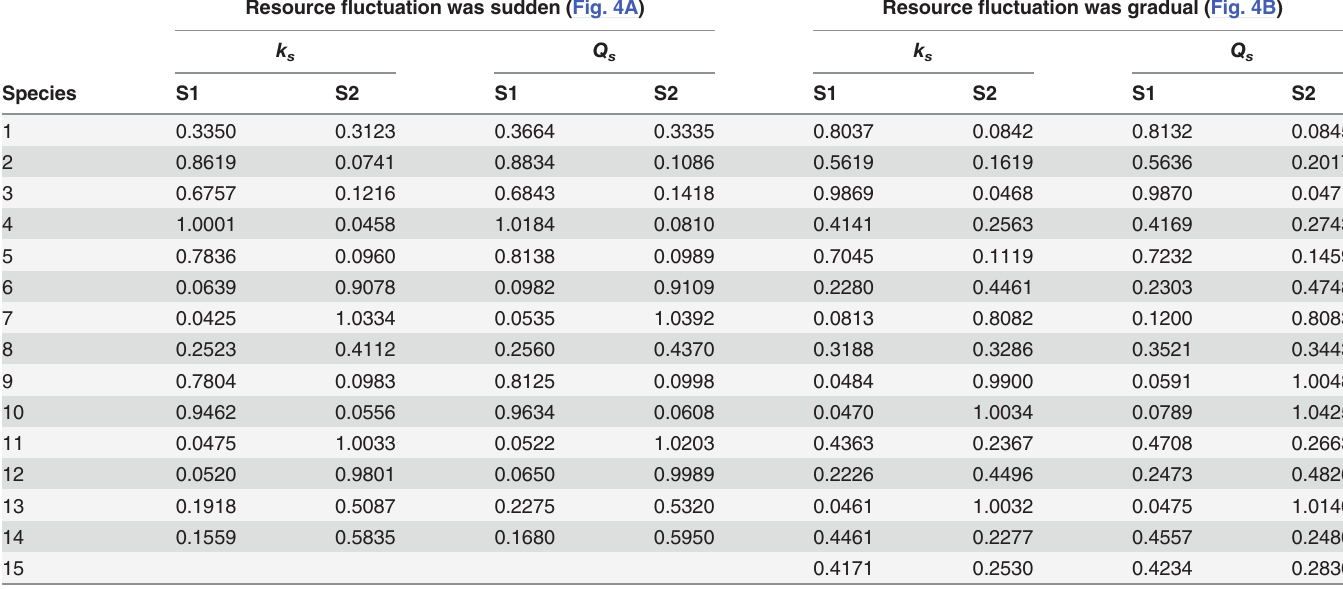
Table 1. Life history traits ( k s and Q s for resources S1 and S2) of species from representative simulations shown in Fig. 4. Resource fl uctuation was sudden (Fig.